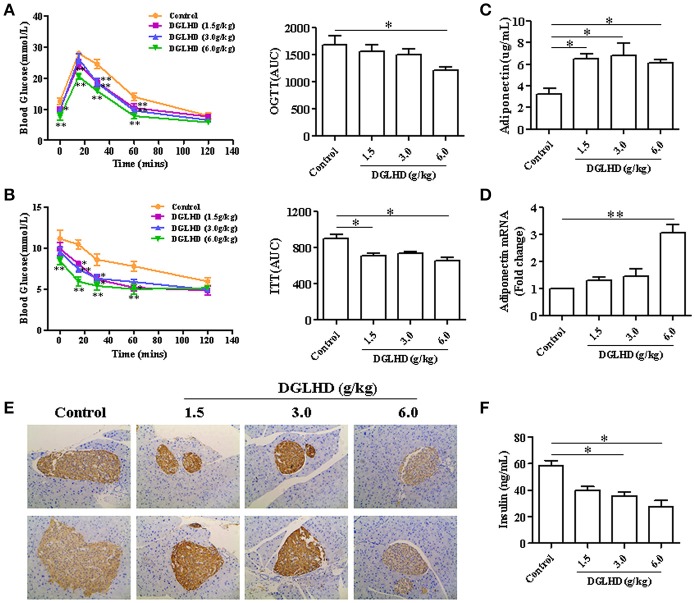
DGLHD improves glucose tolerance and insulin sensitivity in ob/ob mice. Oral glucose tolerance tests (OGTTs) (A) or insulin tolerance tests (ITTs) (B) were performed in mice after 16 or 6 h of food deprivation, respectively. Blood glucose levels were measured before (time 0) and after (15, 30, 60, and 120 min) glucose or insulin administration in ob/ob mice treated daily with water or DGLHD for 8 weeks. AUC, area under the curve of OGTT or ITT. (C,D) Expression levels of adiponectin in serum and VAT. (E) Representative images of insulin immunohistochemical staining in pancreatic islets (×200). (F) Insulin concentrations in serum were assayed by ELISA. Data are presented as mean ± SEM (n = 5). *P < 0.05, **P < 0.01 vs. Control.